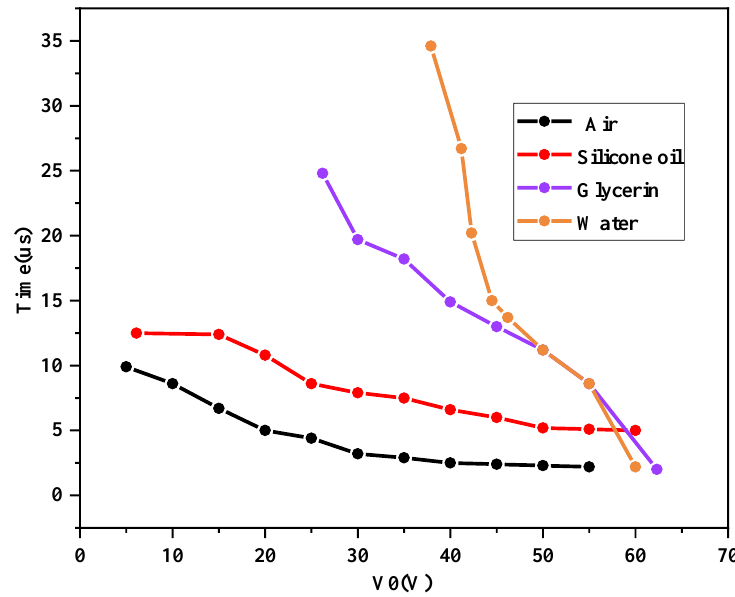
Figure 6. Curves of response time and driving voltage of different material filled switches.